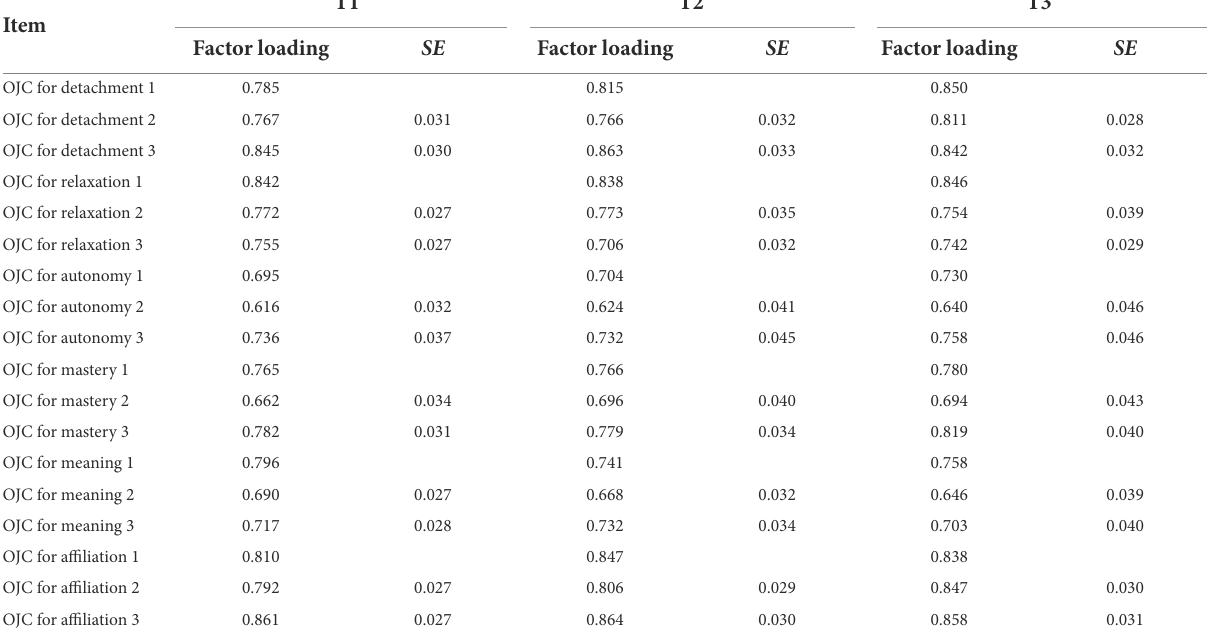
TABLE 3 Standardized Factor Loadings of the NOCS Items, Study 2.